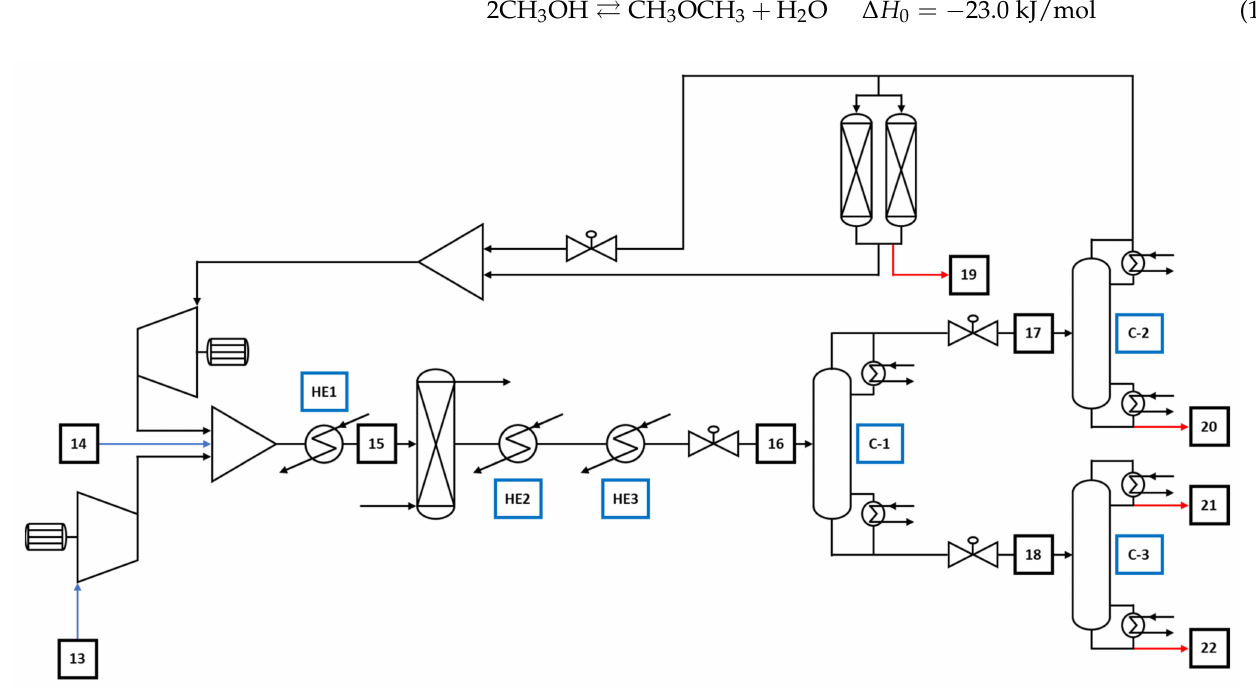
Figure 6. DME production plant block scheme (the tag HE represents the heat exchangers, the tag C represents the columns for product